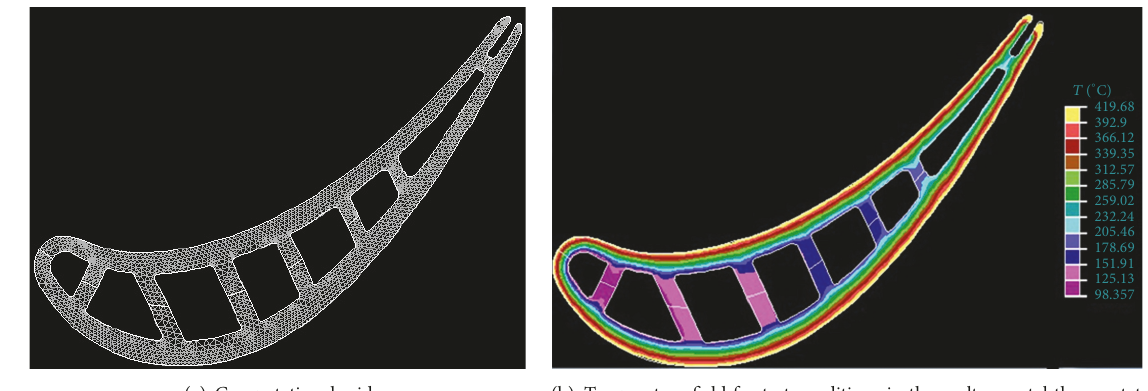
Figure 10: Section 3 of the blade.